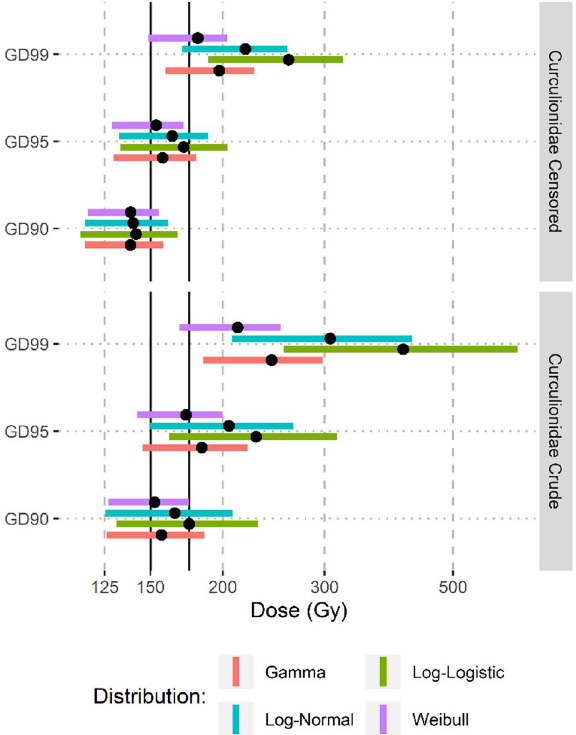
Figure 2. Point estimates and the lower 5% to upper 95% confidence intervals (colored bars) for the generic irradiation dose required to obtain 90, 95 and 99 percent coverage of the family